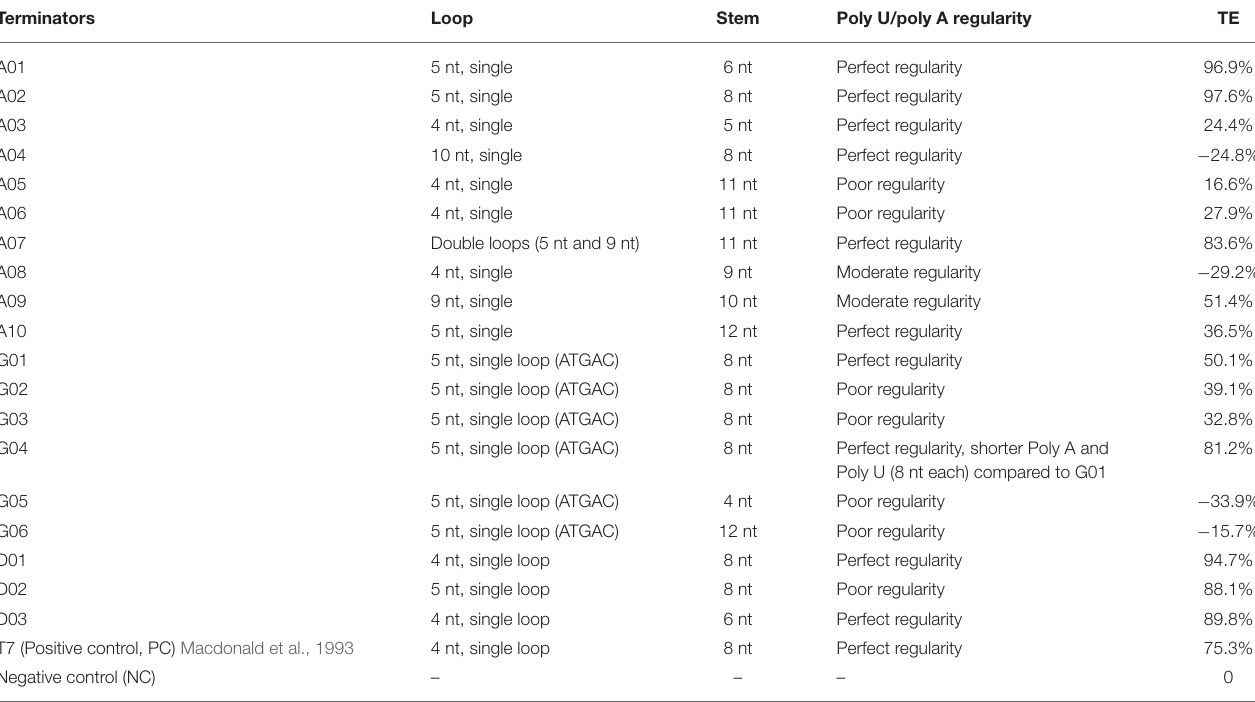
TABLE 3 | The main structural features and termination efficiencies of the native or engineered terminators.